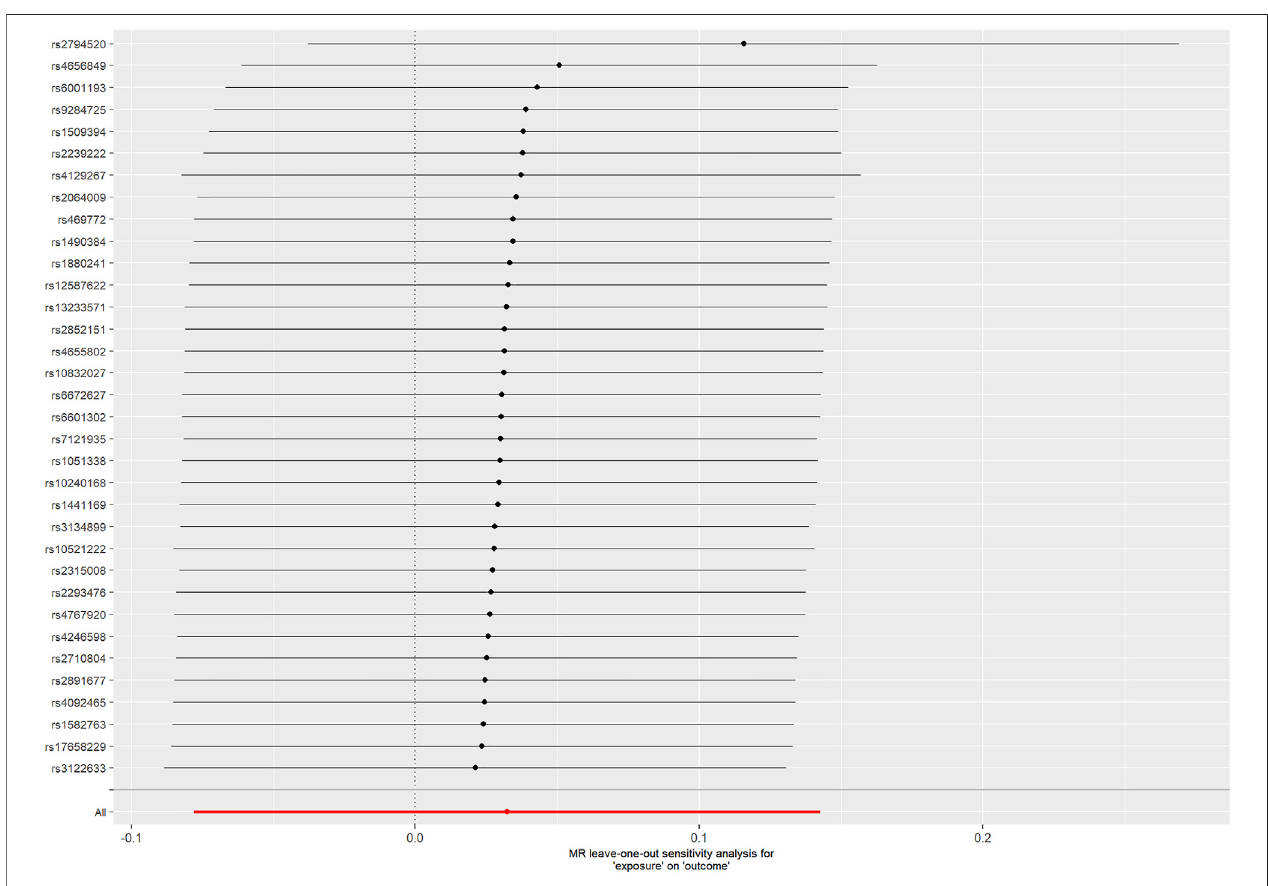
FIGURE 7 | MR leave-one-out sensitivity analysis for CRP on